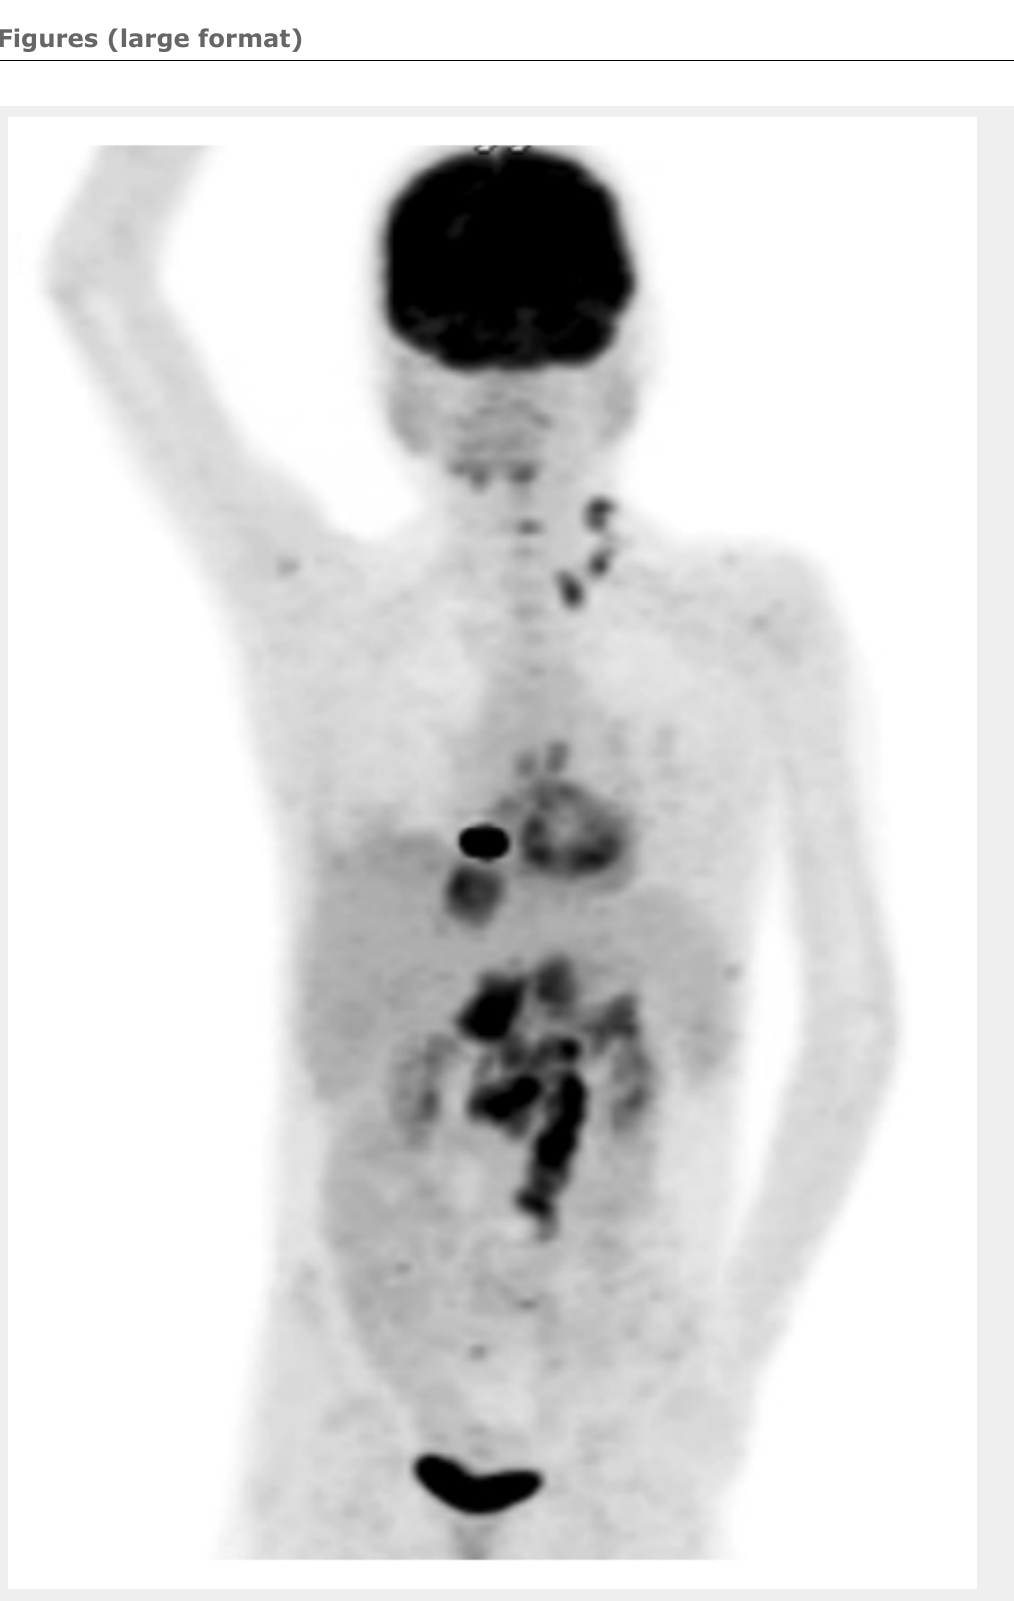
Figure 1 Positron emission tomography-computed tomography scan showing fluorodeoxyglucose uptake in the liver, bones and lymph nodes (highlighted Virchow’s node in the left supraclavicular